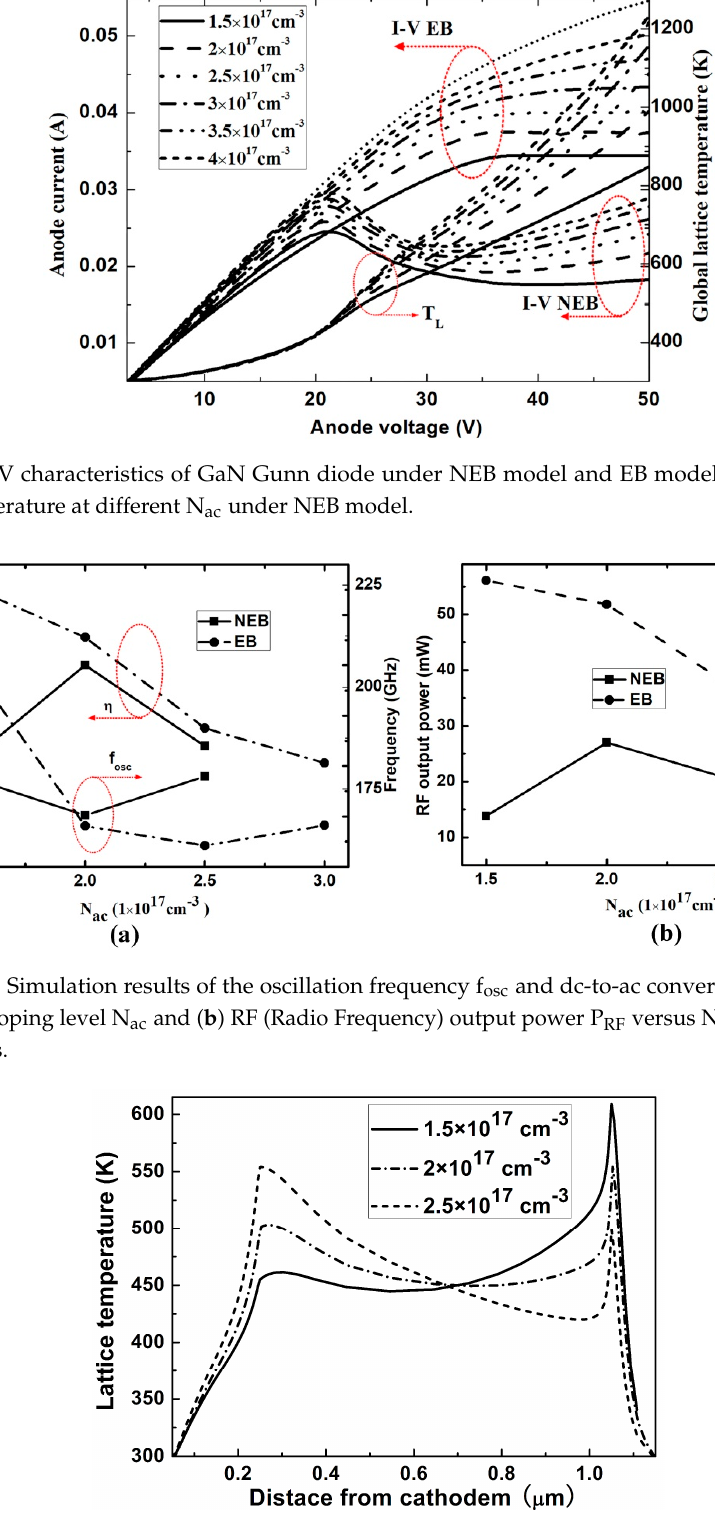
Figure 8. Lattice temperature profiles in the active region at different N ac under NEB model.